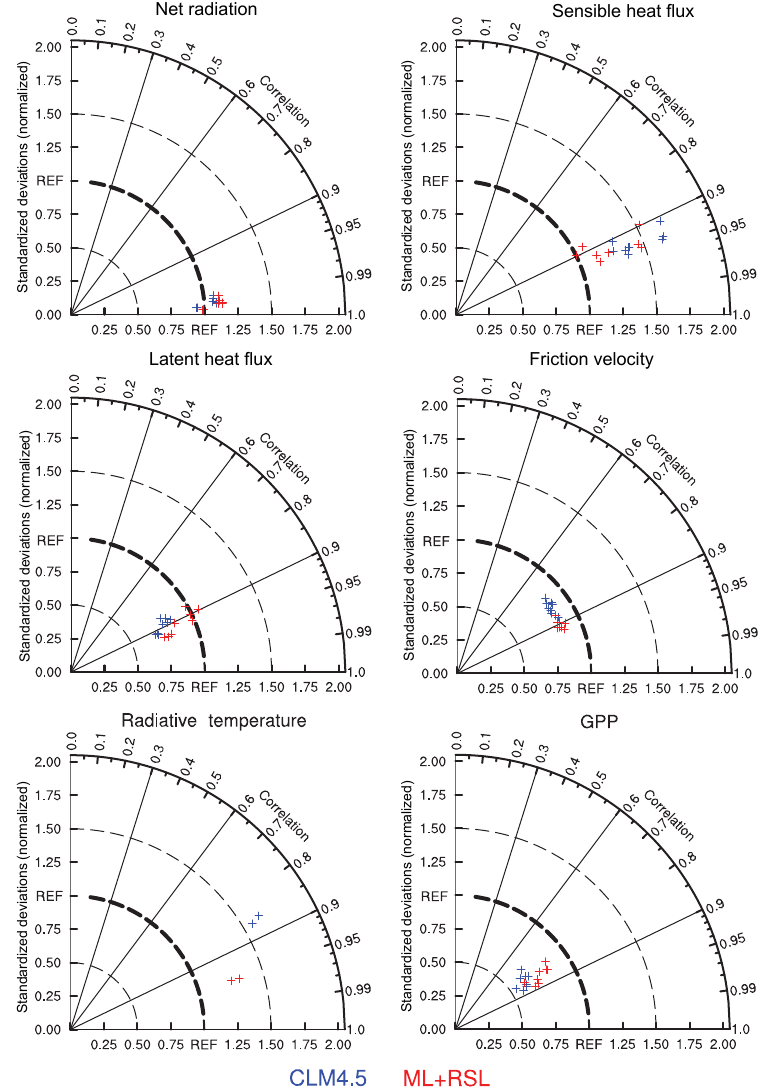
Figure 5. Taylor diagram of net radiation, sensible heat flux, latent heat flux, friction velocity, radiative temperature, and gross primary production (GPP) for US-UMB. Data points are for the years 1999–2006 for CLM4.5 (blue) and ML + RSL (red). Simulations are evaluated with the normalized standard deviation relative to the observations (given by the radial distance of a data point from the origin) and the correlation with the observations (given by the azimuthal position). The thick dashed reference line (REF) indicates a normalized standard deviation equal to 1. Model improvement is seen by radial closeness to the REF line and azimuth closeness to the horizontal axis (correlation coefficient equal to